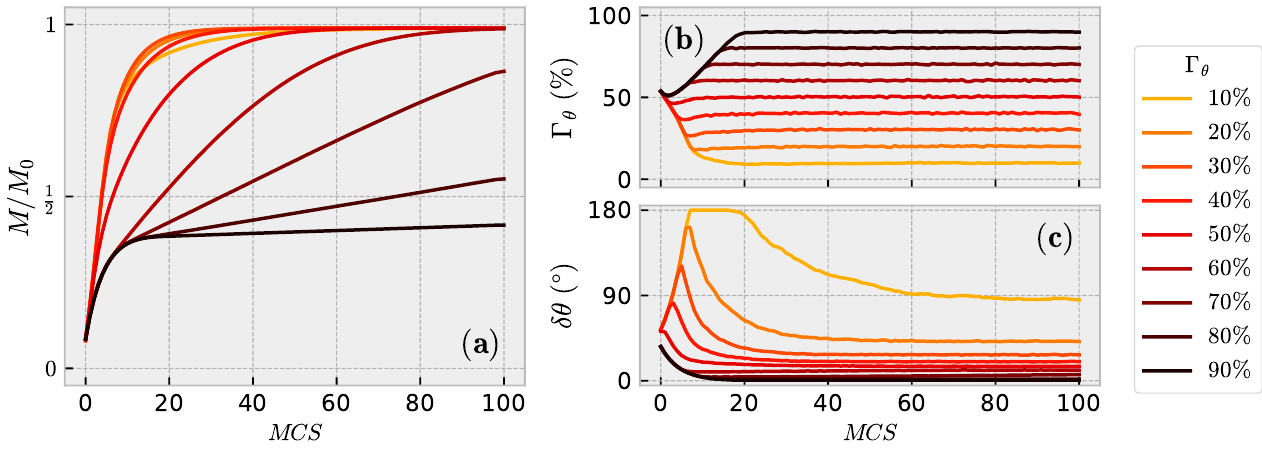
Figure 5. ( a ) Reduced magnetization, ( b ) acceptance rate and ( c ) cone aperture as a function of the Monte Carlo